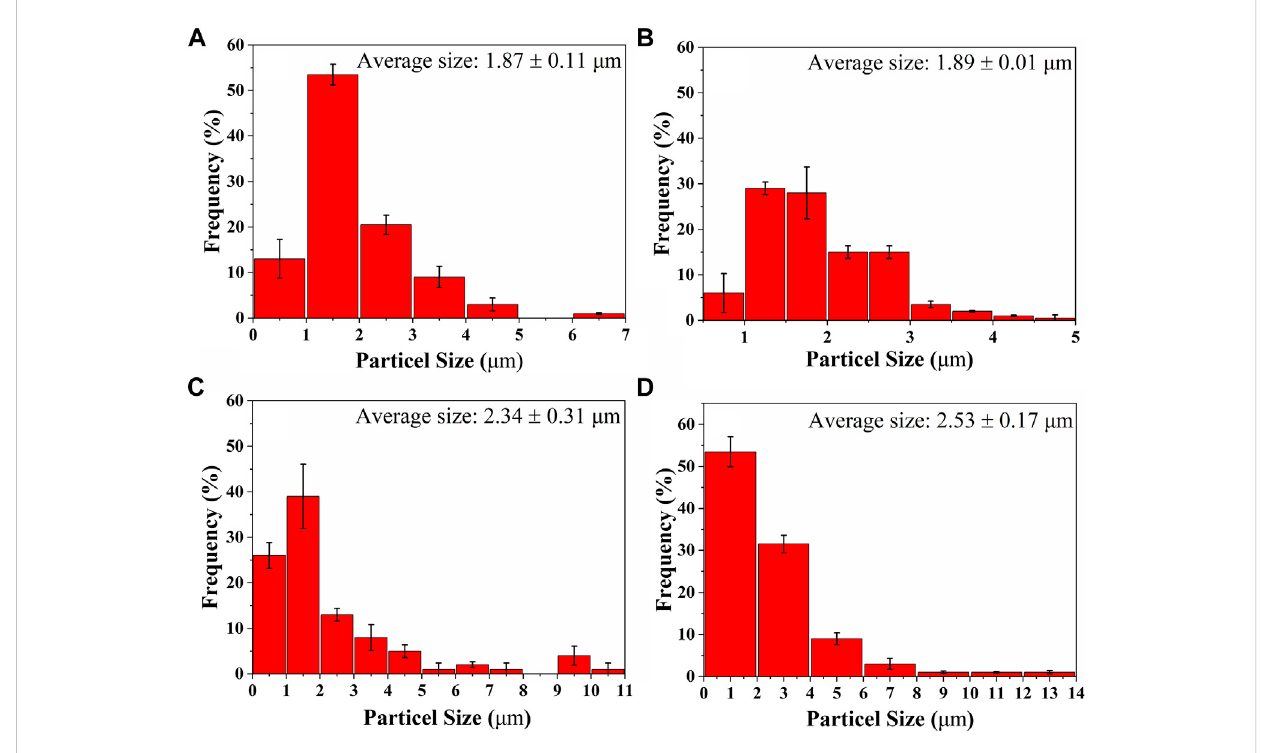
FIGURE 3 Frequency of particle size distribution of soil microaggregates.